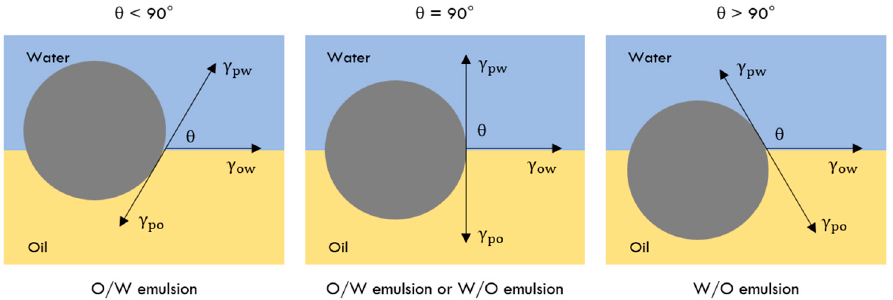
Figure 2. Influence of contact angle, θ , on the location of a solid particle at the oil–water interface. Adapted from